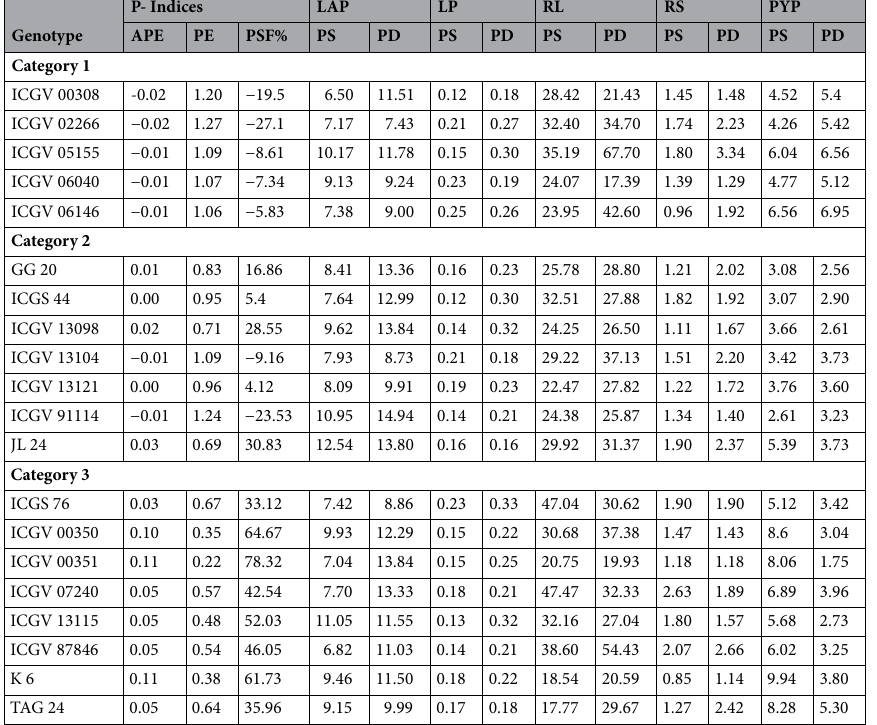
Table 4. Comparison of genotypes for P-efficiency traits, yield and P-indices. LP%—Leaf phosphorus (%), LAP—Leaf acid phosphatase (µM/hr/gm), RL—Root length (cm), R: S—Root: Shoot ratio, PYP—Pod yield per plant (g), APE—Agronomic phosphorus use efficiency; PE—Phosphorus efficiency; PSF (%)—Phosphorus stress factor percentage; PS- Phosphorus sufficient; PD- Phosphorus